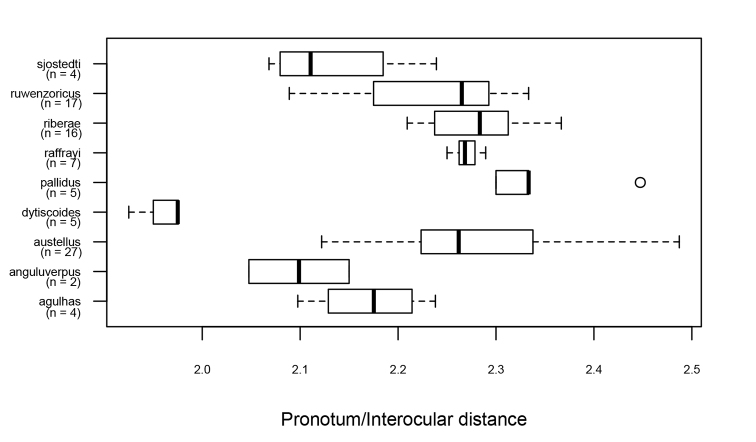
The ratio between pronotal width and interocular distance in males of the Agabus
raffrayi group. Symbols as in Fig. 12. Note the very narrow pronotum of A.
dytiscoides, a distinguishing feature of this species.